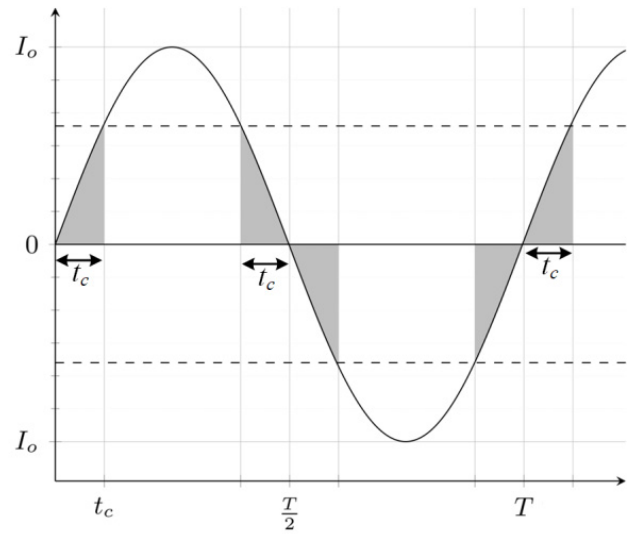
Figure 4. Representation of the zones (in grey) where the combination of deadtime and output current are not enough to respectively charge and discharge the parasitic output capacitances of the SiC MOSFET and SiC Diode in a inverter leg configuration.